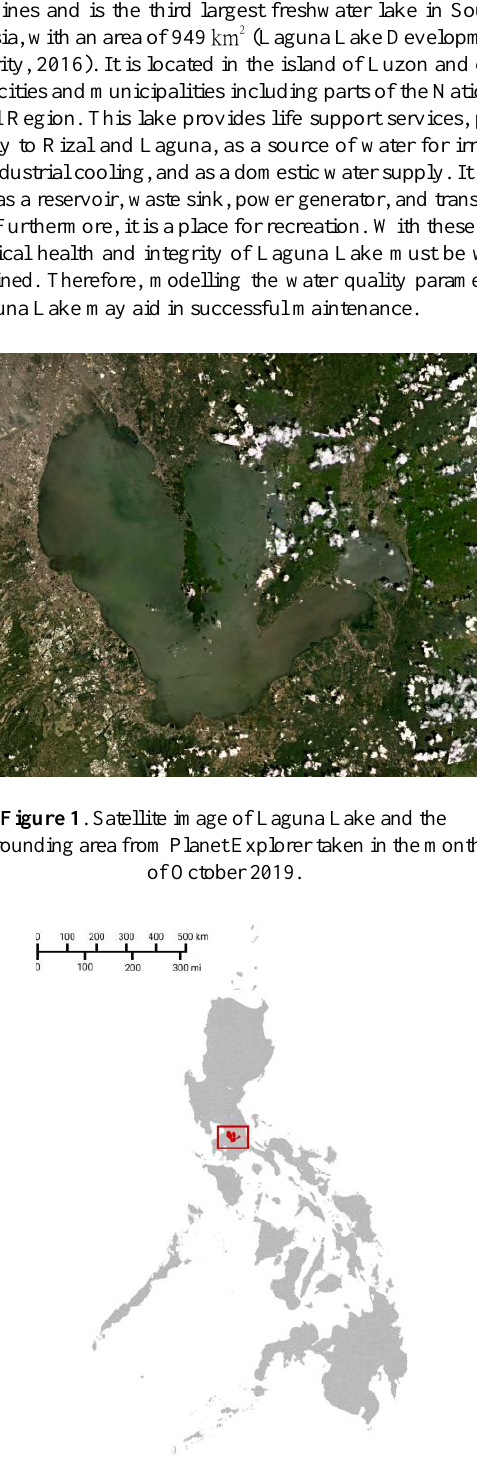
Figure 2 . Map of the Philippines with Laguna Lake highlighted and boxed in red.